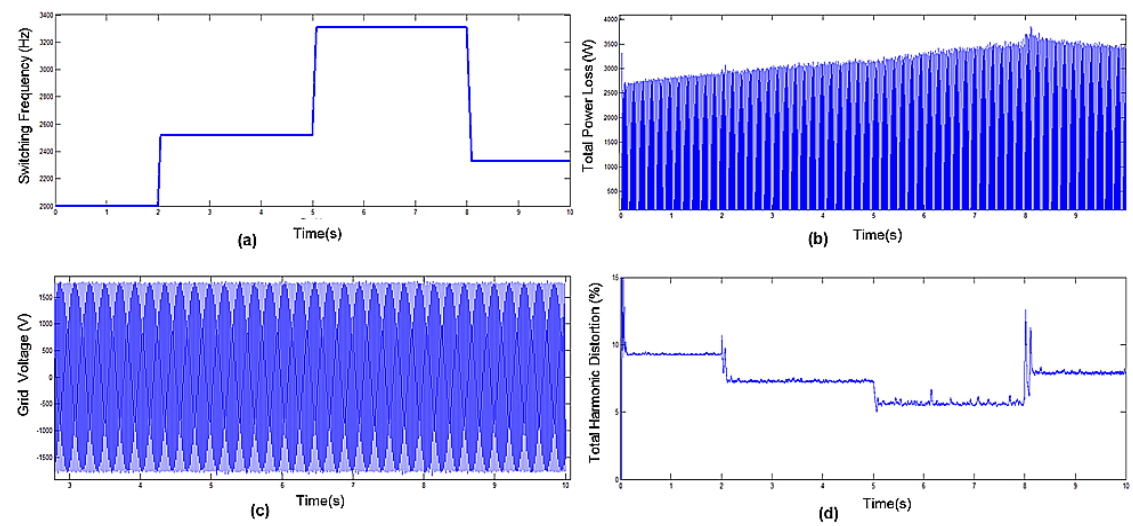
Figure 10. ( a ) Controlled power loss data by dynamic DC link and frequency operation; ( b ) Power losses; ( c ) Three phase grid voltage; ( d ) Total harmonic distortion.